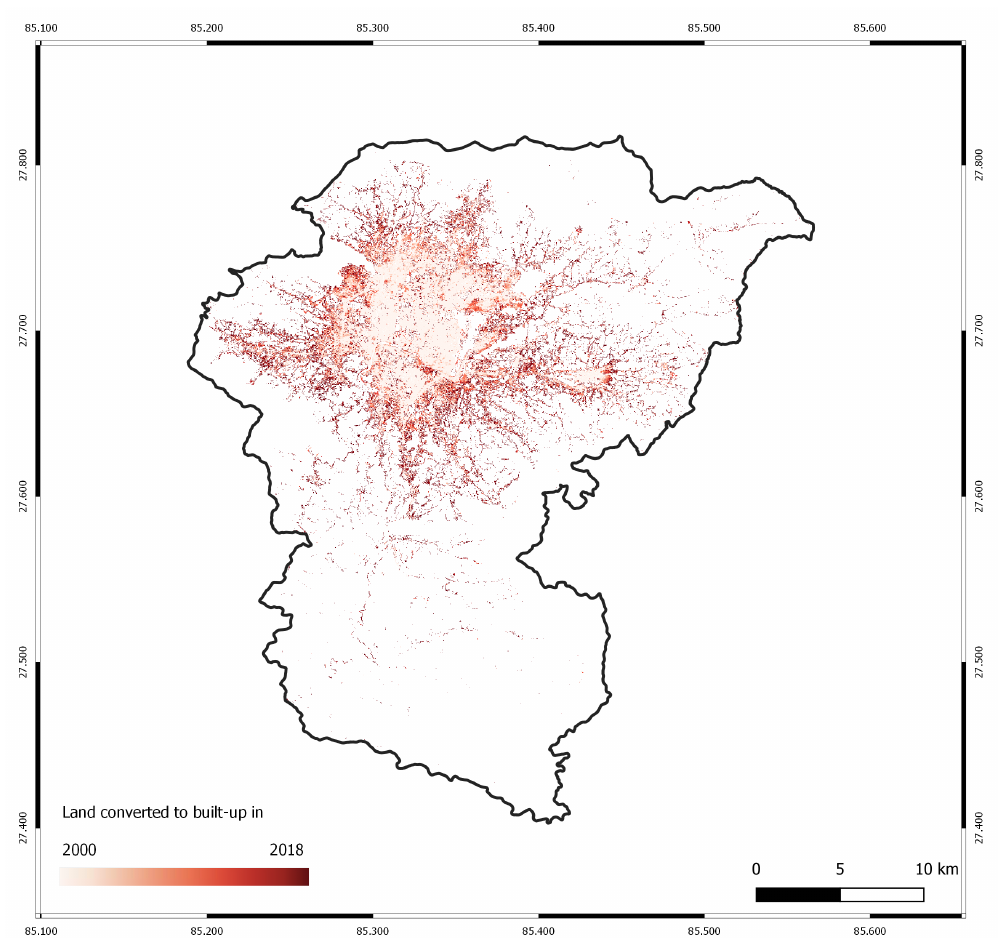
Figure A2. Map showing when land class changed to built-up areas in each area: The deeper red represents newer changes while the lighter color signifies older changes. White color represents areas that are not